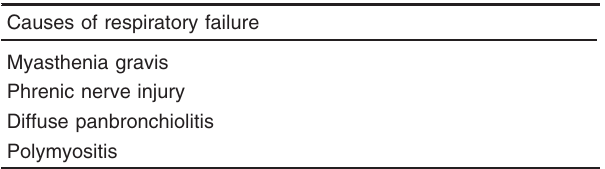
Table 1 List of causes of respiratory failure described in patients with thymoma Causes of respiratory failure Myasthenia gravis Phrenic nerve injury Diffuse panbronchiolitis